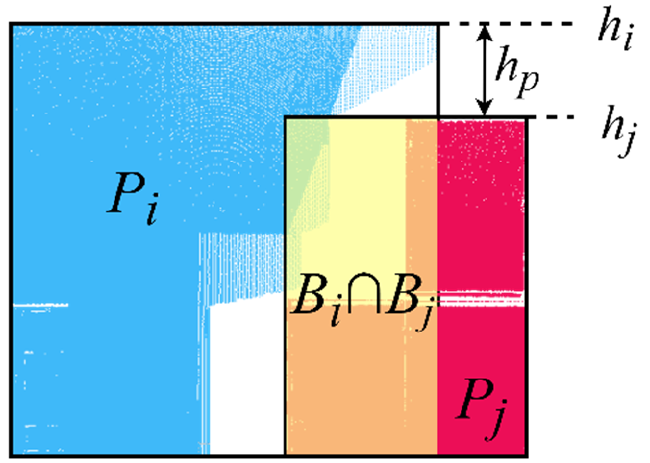
Figure 4. Merging alternative wall surfaces. The blue area and the red area are different alternative wall surfaces. The black frame is the oriented bounding box. The translucent yellow area is the intersection area of the oriented bounding boxes.